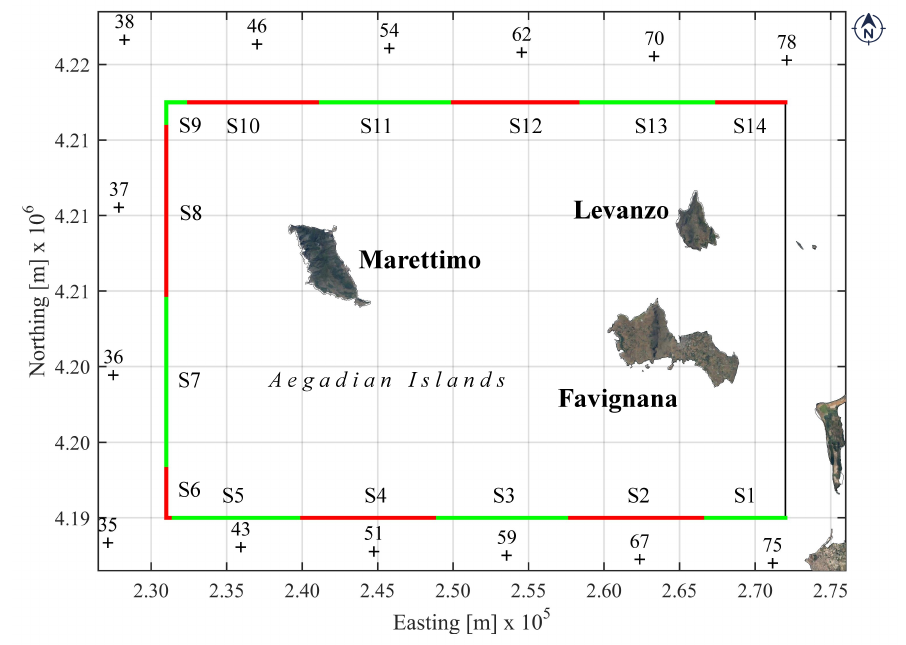
Figure 3. The coloured rectangle is the SWAN model domain. Each side of the rectangle is divided in sectors, named by an upper-case letter (S1, S2, ..., S14) representing different offshore boundary conditions (see Table 1). The crosses represent the point of hind-cast dataset by [41–43] used to force the model offshore boundary conditions.